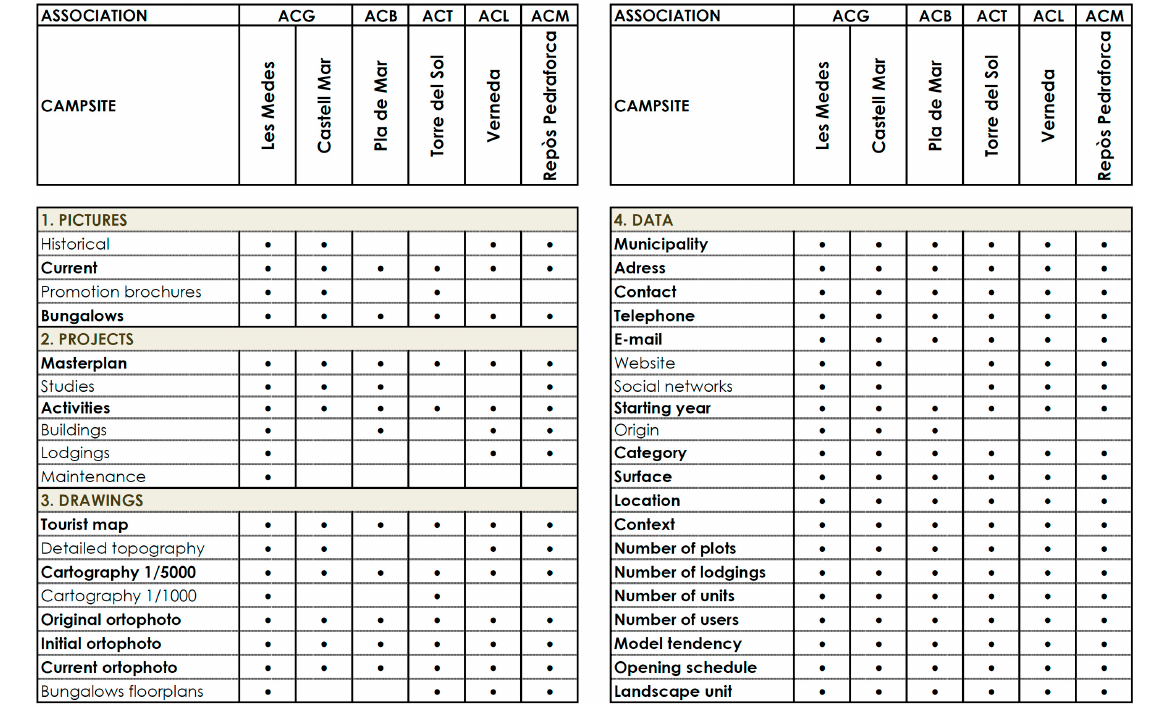
Figure 3. Comparative analysis of the information collected for each case study. Common and most relevant documents for the study are highlighted in bold type (Source: authors’